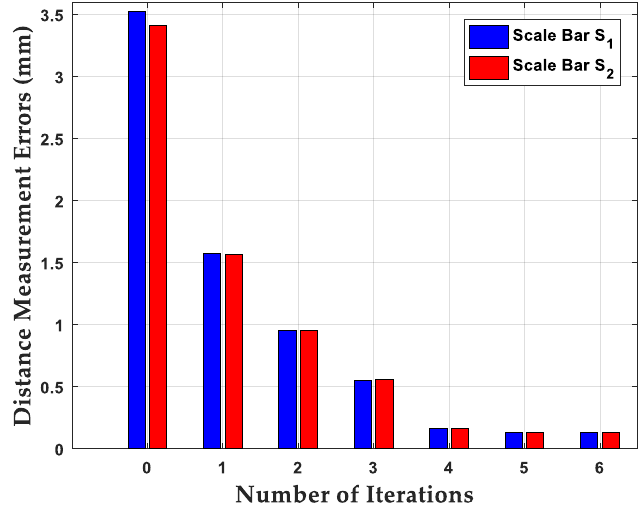
Figure 7. Distance estimation error iteration at each iteration by bundle adjustment.